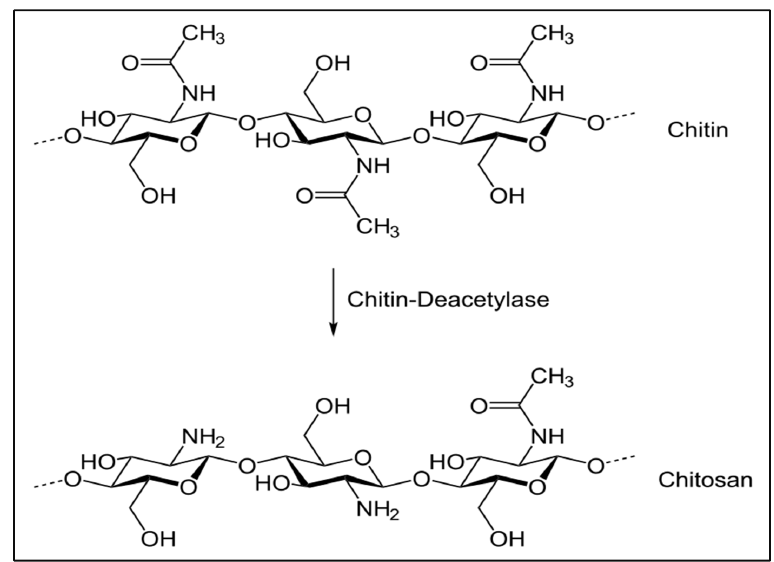
Figure 1. Formation of chitosan by partial deacetylation of chitin In addition, depending on the origin of the polymer and treatment during the extrac- tion process, chitosan shows crystallinity and polymorphism. Chitin, or 0% deacetylated and fully deacetylated chitosan, or 100% deacetylated, had the highest crystallinity. In